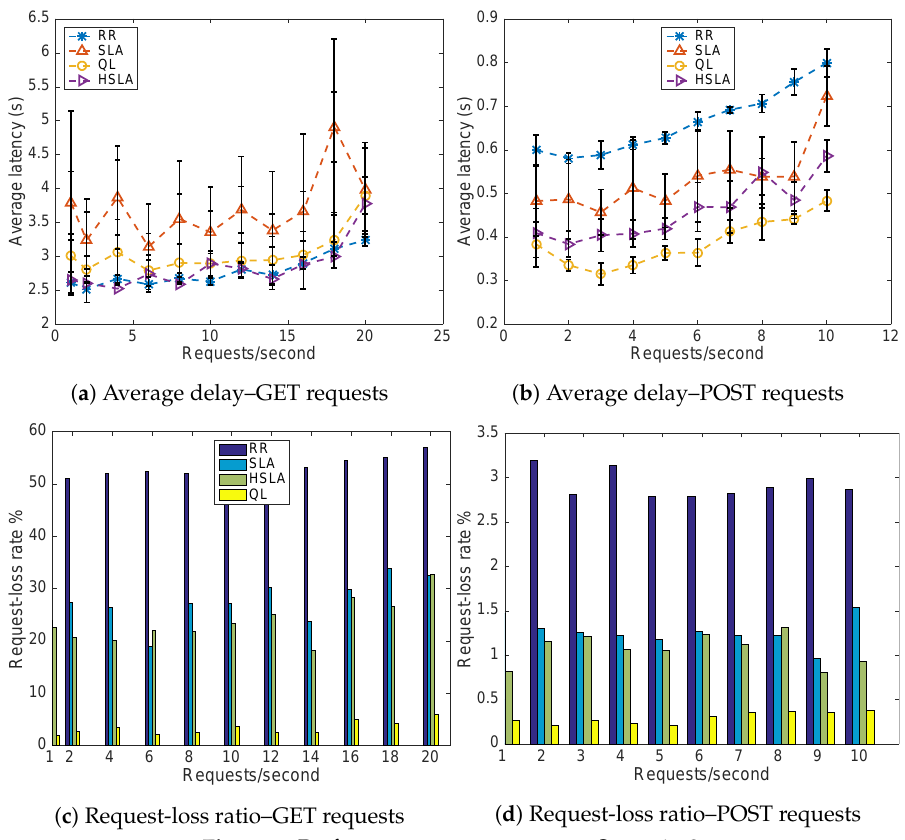
Figure 6. Performance measurements—Scenario-3.